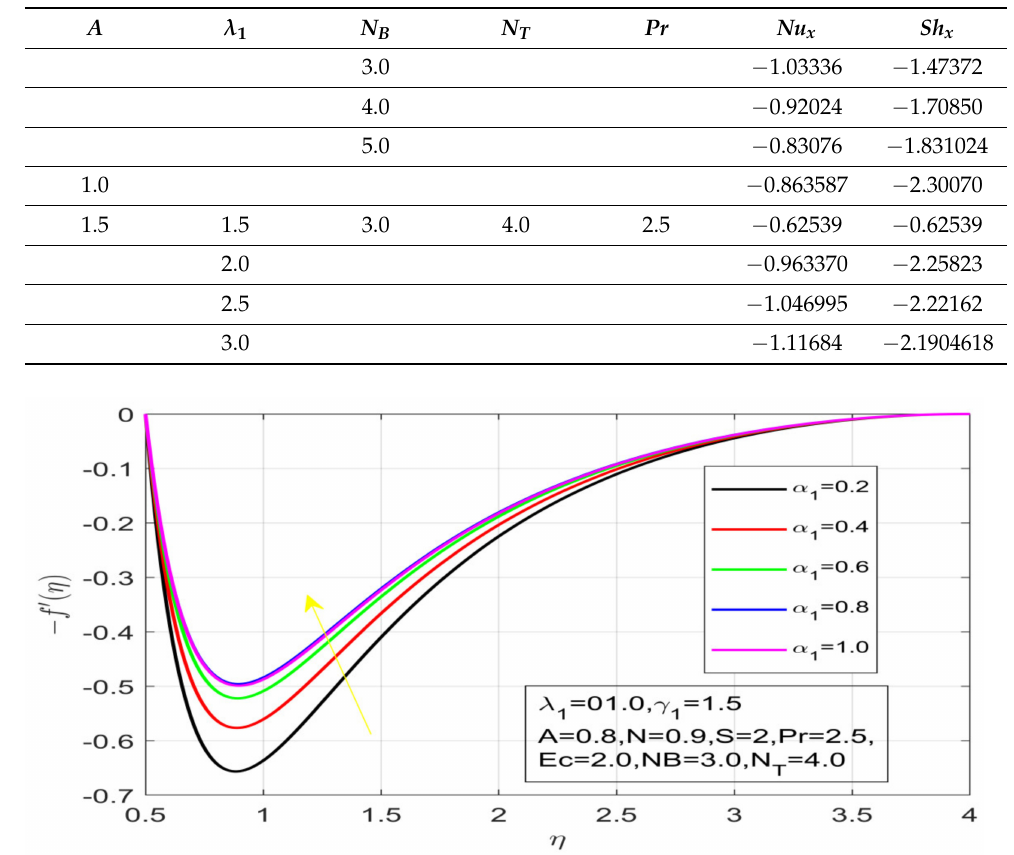
Figure 3. Influence of α _1 on the velocity distribution.